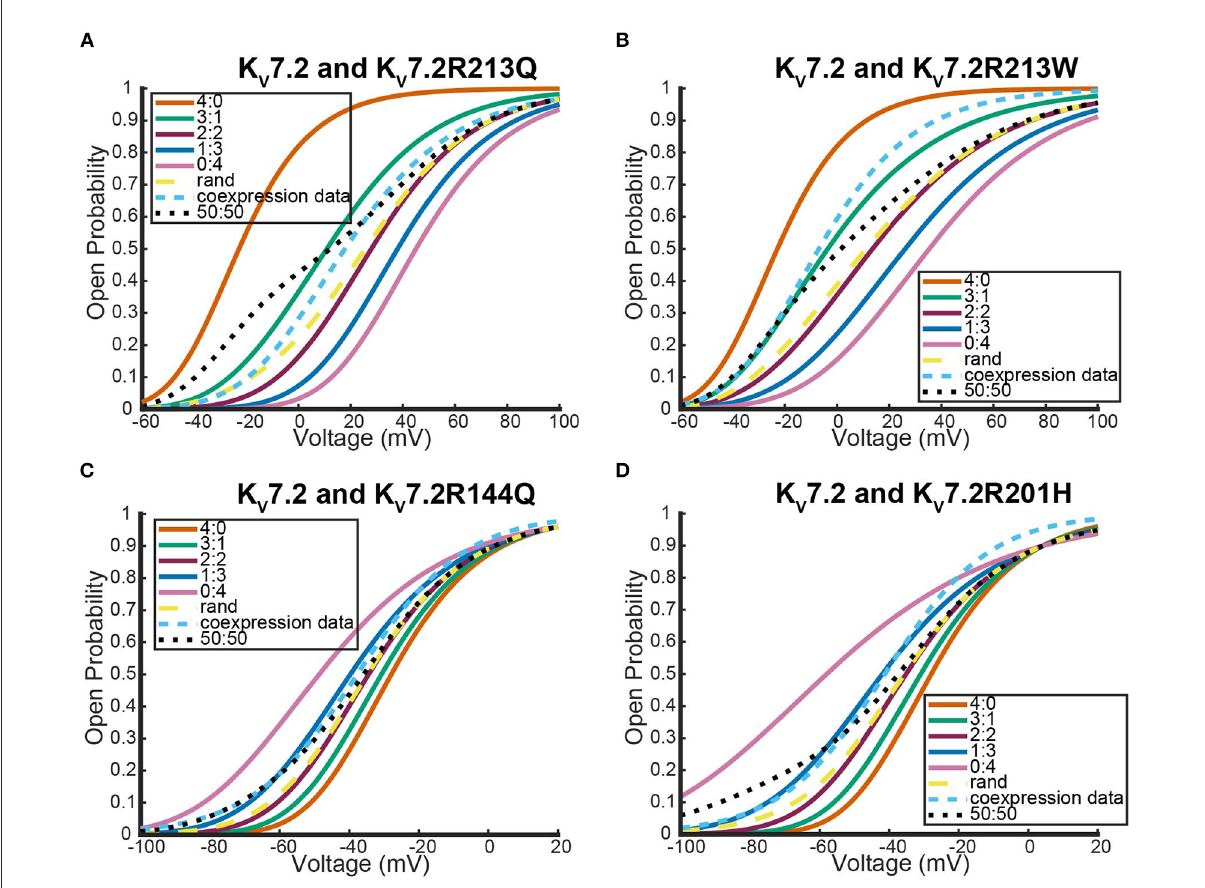
FIGURE10 Steady state probability curves as a function of voltage for cells containing various channel types in four different experiments. The coexpression data and homomeric data for model fitting was taken from (A,B) Miceli et al. (2013) and (C,D) Miceli et al. (2015). The steady state probability curves presented here are for homomeric K v 7.2 (4:0) and K v 7.2 mutant (0:4) channels, heteromeric assembly of K v 7.2 and K v 7.2 mutant subunits (3:1, 2:2, 1:3), the model output of a random assembly of K v 7.2 and K v 7.2 mutant subunits expressed in 50:50 ratio (rand), the data output of a 50:50 expression of K v 7.2 and mutant K v 7.2 subunits (coexpression data), and a model output of an equal split between only homomeric channels (50:50). Curve color and type are shown in the legends. Homomeric channels and their related heteromers being looked at are also detailed in figure